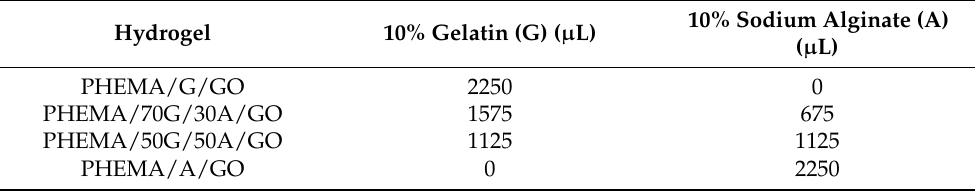
Table 2. Composition of the gelatin and sodium alginate solutions and designation of the hydrogels.